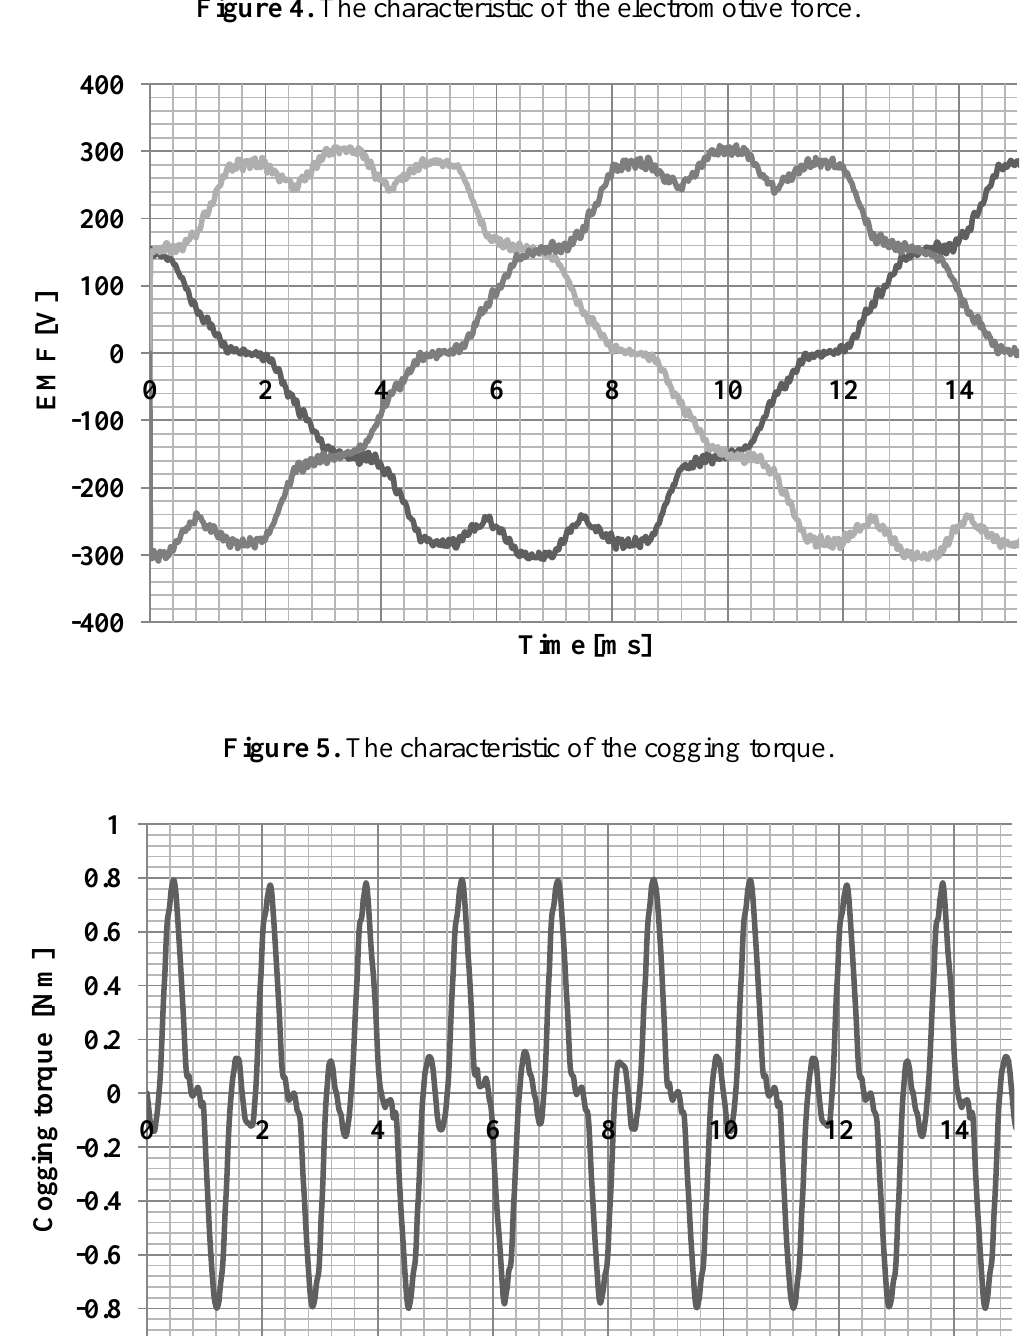
Figure 4. The characteristic of the electromotive force.